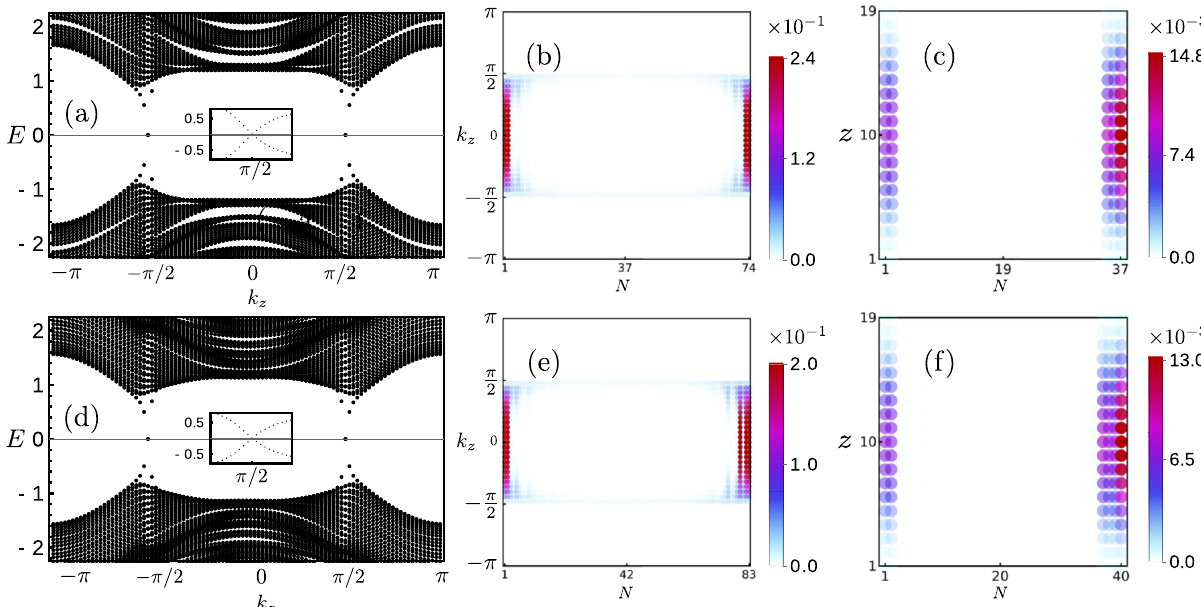
Fig. 6 Projected Weyl semimetal (PWSM). PWSM is constructed by stacking 1D projected Chern insulator in the z direction in a translationally invariant fashion. The underlying 1D chain is inclined at a rational [irrational] slope in the parent 2D square lattice in ( a – c ) [( d – f )]. a Energy spectra of H PTB ( k z ) [Eq. (1)] for m = 4 and t = t z = 2 t 0 = 1 [Eqs. (3) and (4)], displaying two Weyl nodes at k z = ± π /2 (see Inset). Here k z is measured in units of a − 1 and we impose periodic boundary condition in both x and y direction. b Fermi arc states of H PTB ( k z ) in between two Weyl nodes with open boundary conditions in the x and y directions. As we approach the Weyl nodes, the Fermi arcs get delocalized, and at k z = ± π /2 they leak through the bulk to connect two ends of the underlying projected 1D chain. For ( a ) and ( b ) the linear dimension of the square lattice is L = 32 in both x and y directions, and the 1D chain is constructed with x u = 8 and x d = 6, such that it contains 19.7% [( a – c )] and 20.0% [( d – f )] of the sites of parent square lattice [Fig. 1]. c Fermi arcs with open boundary conditions along all three directions in a system with linear dimensions L = 16 in the x and y directions, and L = 19 in the z direction. The 1D brain for each z is constructed with x u = 7 and x d = 5 in ( a – c ), and x u = 8 and x d = 6 in ( d – f ), respectively containing 14.5% and 15.6% of the sites of the parent 3D cubic lattice. The local density of states shows left-right asymmetry as the embedded 1D chain breaks such symmetry in the parent 2D square lattice [Fig. 1]. d – f Are analogous to ( a – c ), respectively.